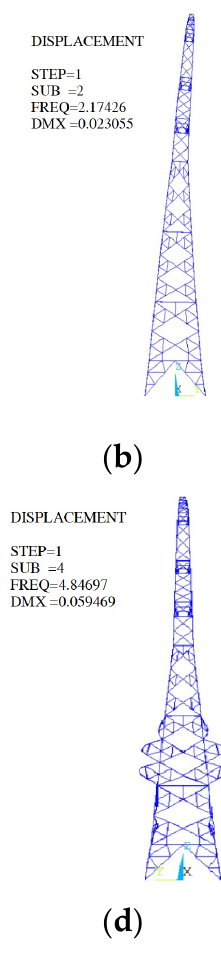
Figure 8. The vibrations of a single tower: ( a ) 1st mode; ( b ) 2nd mode; ( c ) 3rd mode; ( d ) 4th